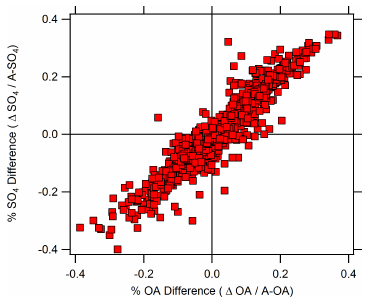
Figure 7. Scatterplot of percent difference in SO 4 ( y axis) and OA ( x axis) for the entire campaign. The percent difference is calculated as (cid:49) species / above-canopy species concentration and is represen- tative of the normalized (cid:49) species